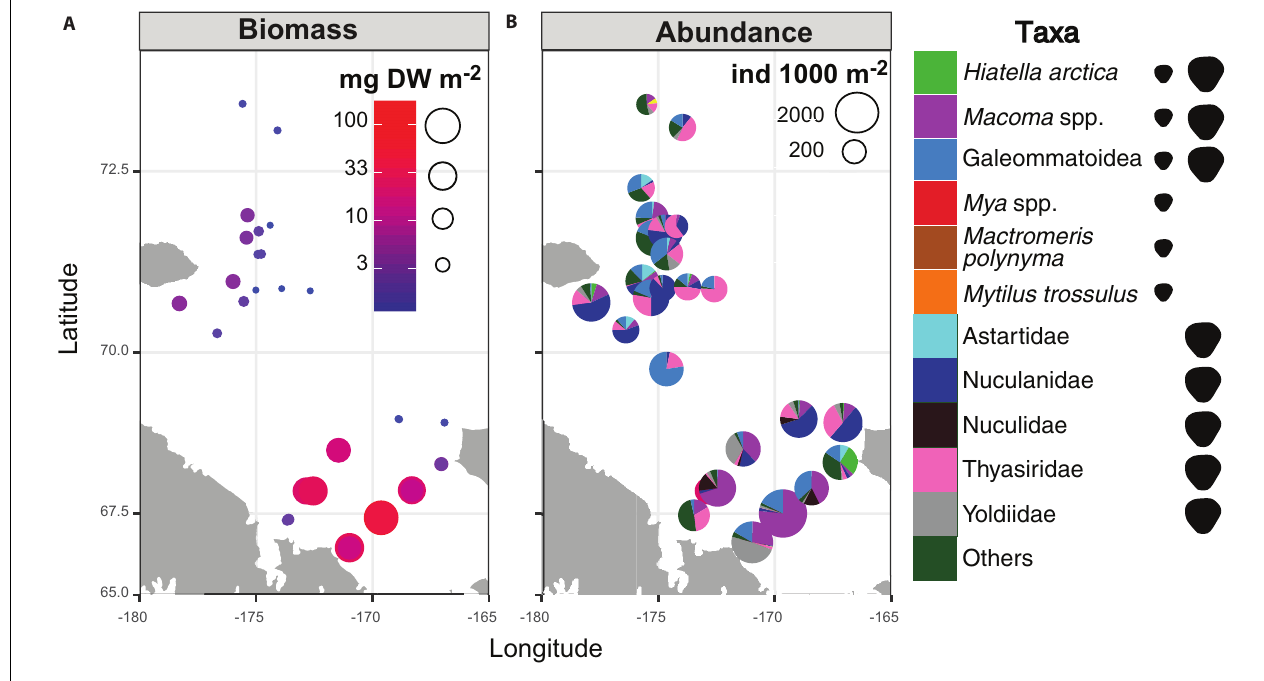
FIGURE 4 | Distribution of (A) biomass and (B) abundance and taxonomic composition of adult bivalves in the Chukchi Sea. Symbols to the right of the legend indicate the presence of taxa in the Chukchi Sea as planktonic larvae, adults, or both.